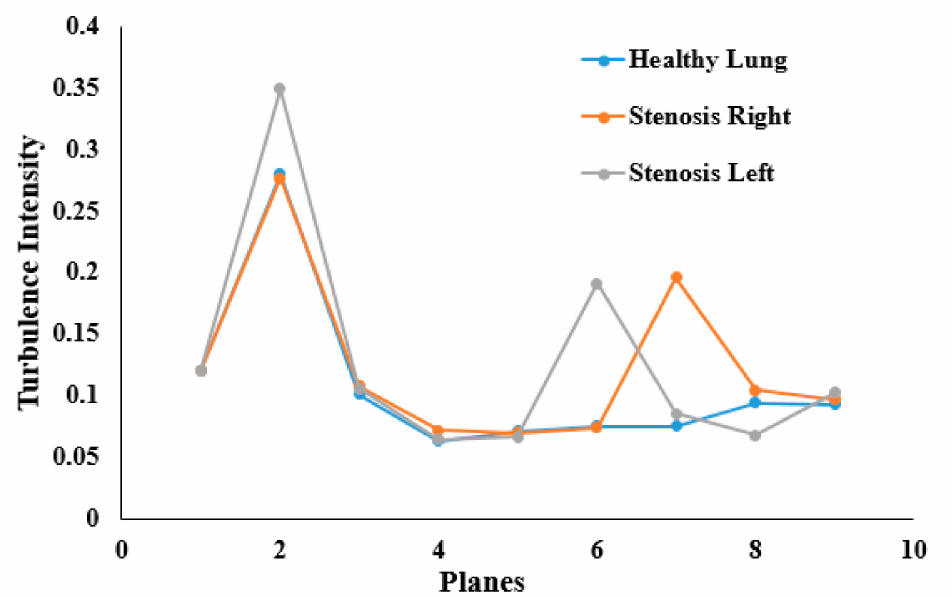
Figure 14. Turbulence intensity at di ff erent plane positions of the whole lung models at 30 lpm.